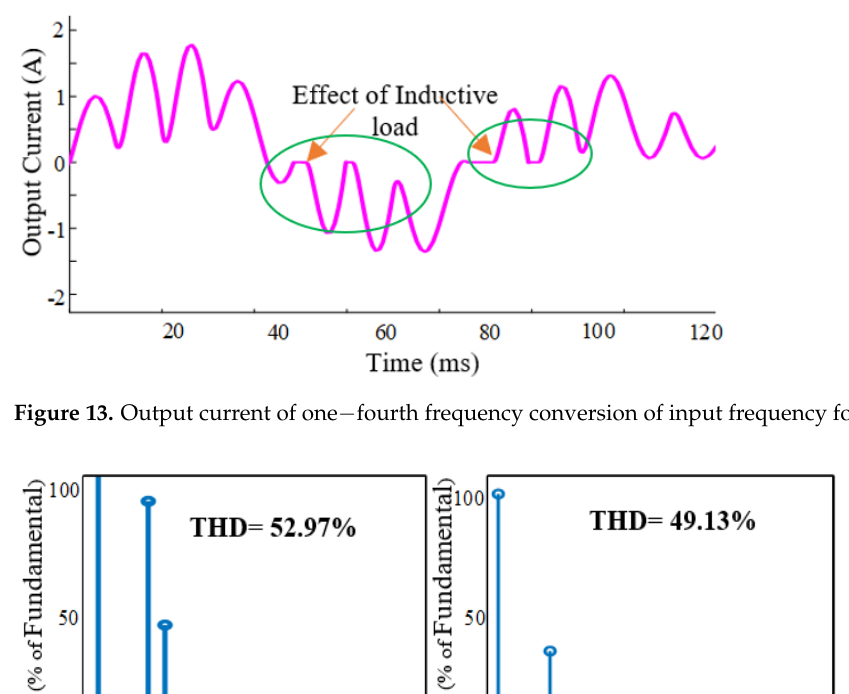
Figure 12 . Output voltage of one − fourth frequency conversion of input frequency for motor load.